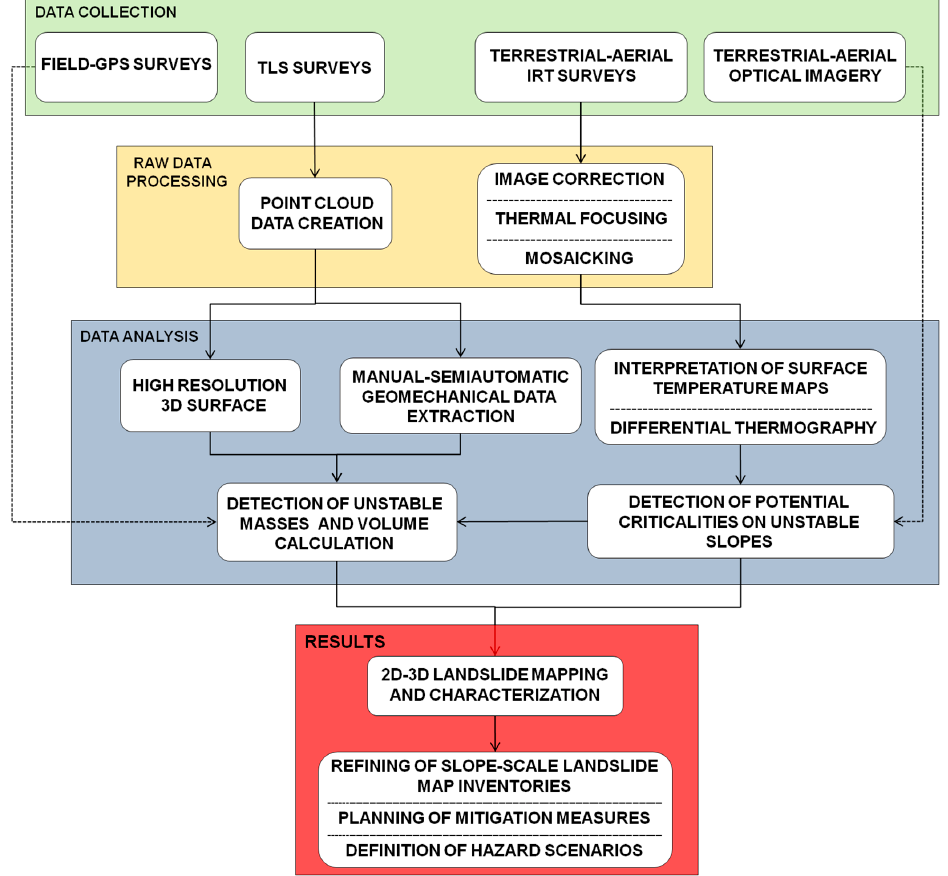
Figure 6. Workflow of the implemented methodology.